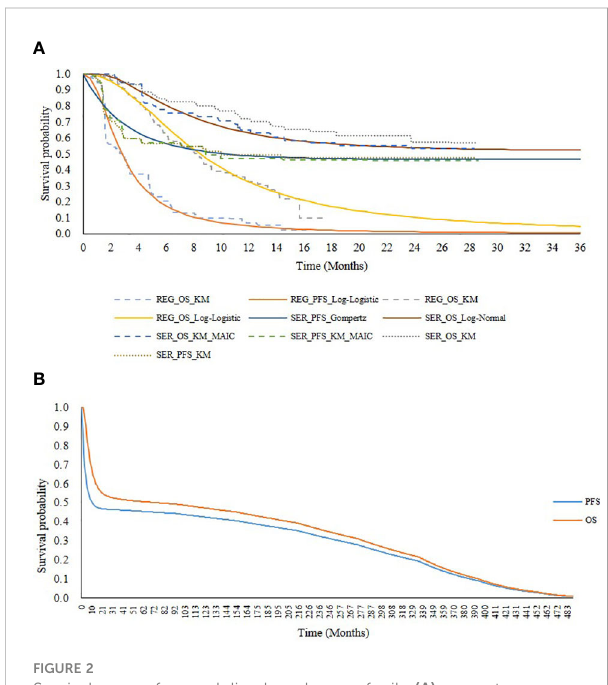
FIGURE 2 Survival curves for serplulimab and regorafenib. (A) presents extrapolation and fi tting of survival outcomes from the ASTRUM-010 and CONCUR trial. (B) presents PFS and OS curves adjusted with increase of death risk in serplulimab overtime horizon. SER, serplulimab; REG, regorafenib; KM, Kaplan-Meier; PFS, progression free survival; OS, overall survival; MAIC, matching-adjusted indirect